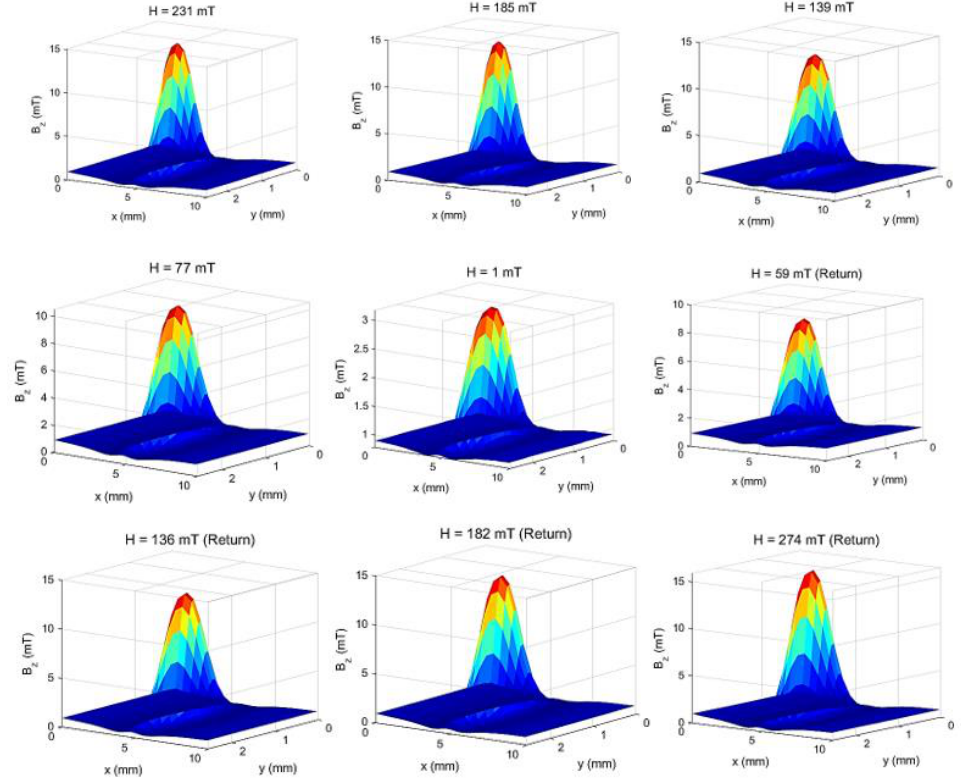
Figure 6. Magnetic maps obtained through a scanning magnetic microscope, field from 231 mT to 1 mT, and back to 274 mT. 1 mT, and back to 274